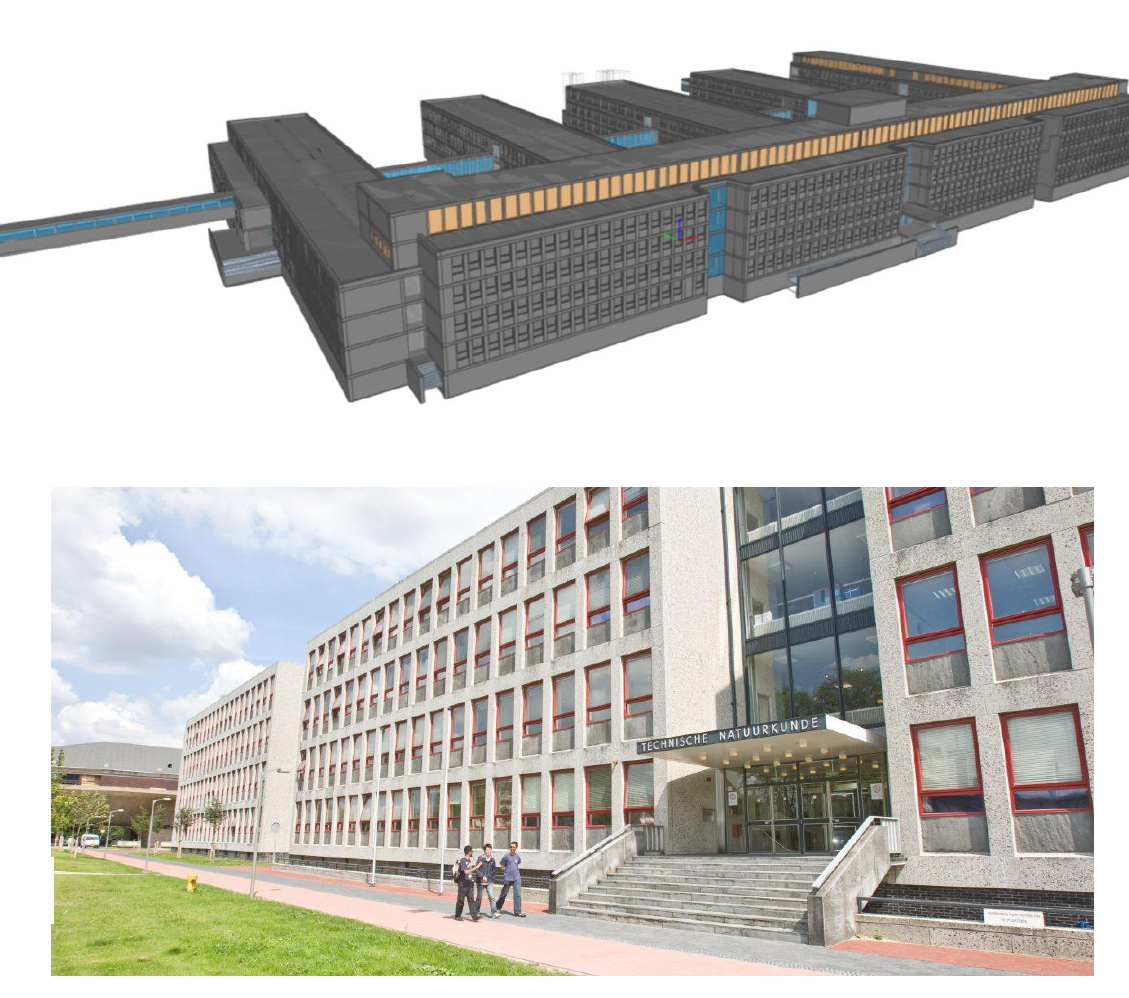
Figure 5. 3D model for Faculty of Applied Sciences (upper) and real picture of the entrance (bottom)